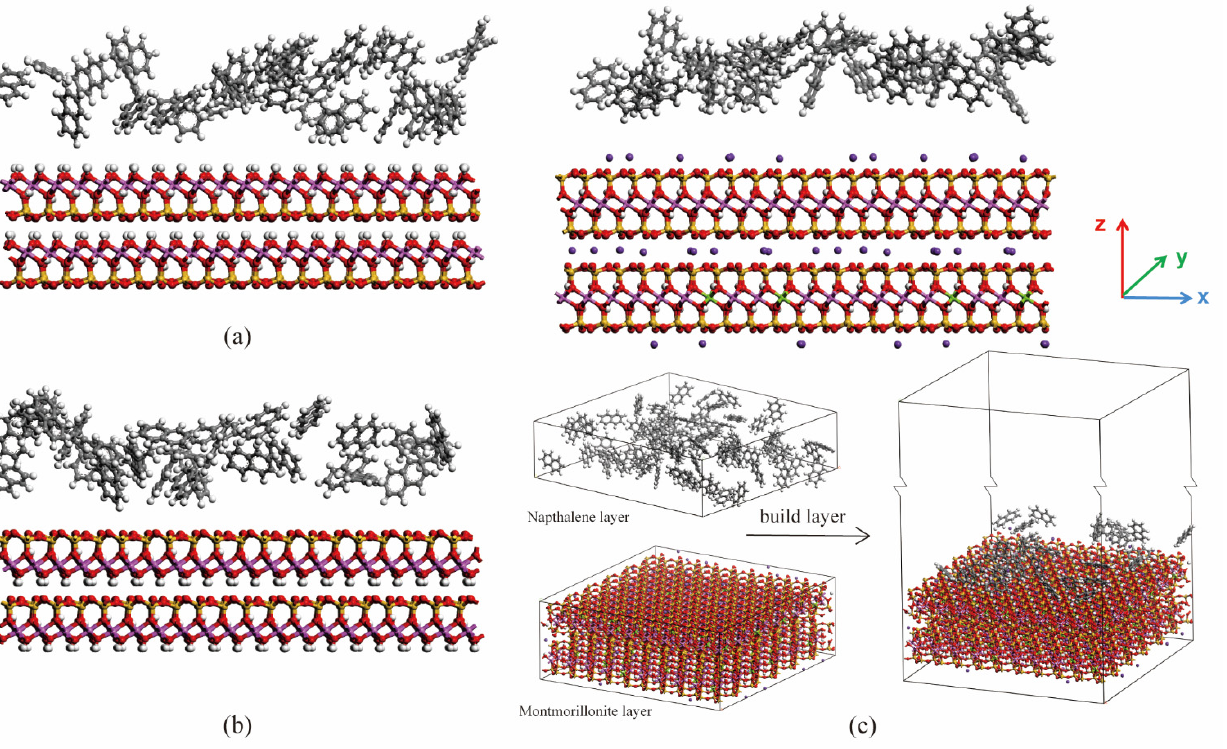
Figure 1. The initial configuration of the binary model for ( a ) kaolinite (aluminum octahedral surface); ( b ) kaolinite (silicon tetrahedral surface); ( c ) montmorillonite.